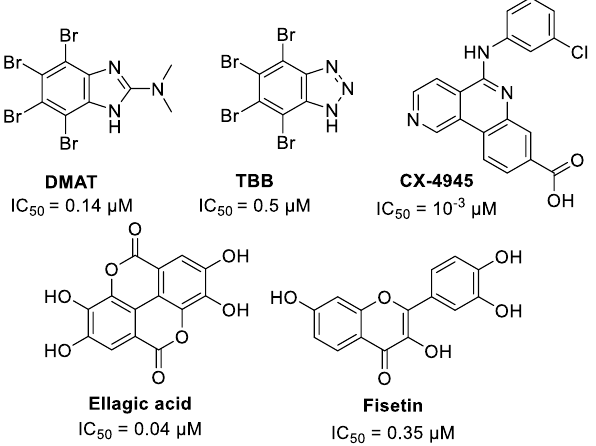
Figure 1. Representative CK2 inhibitors.